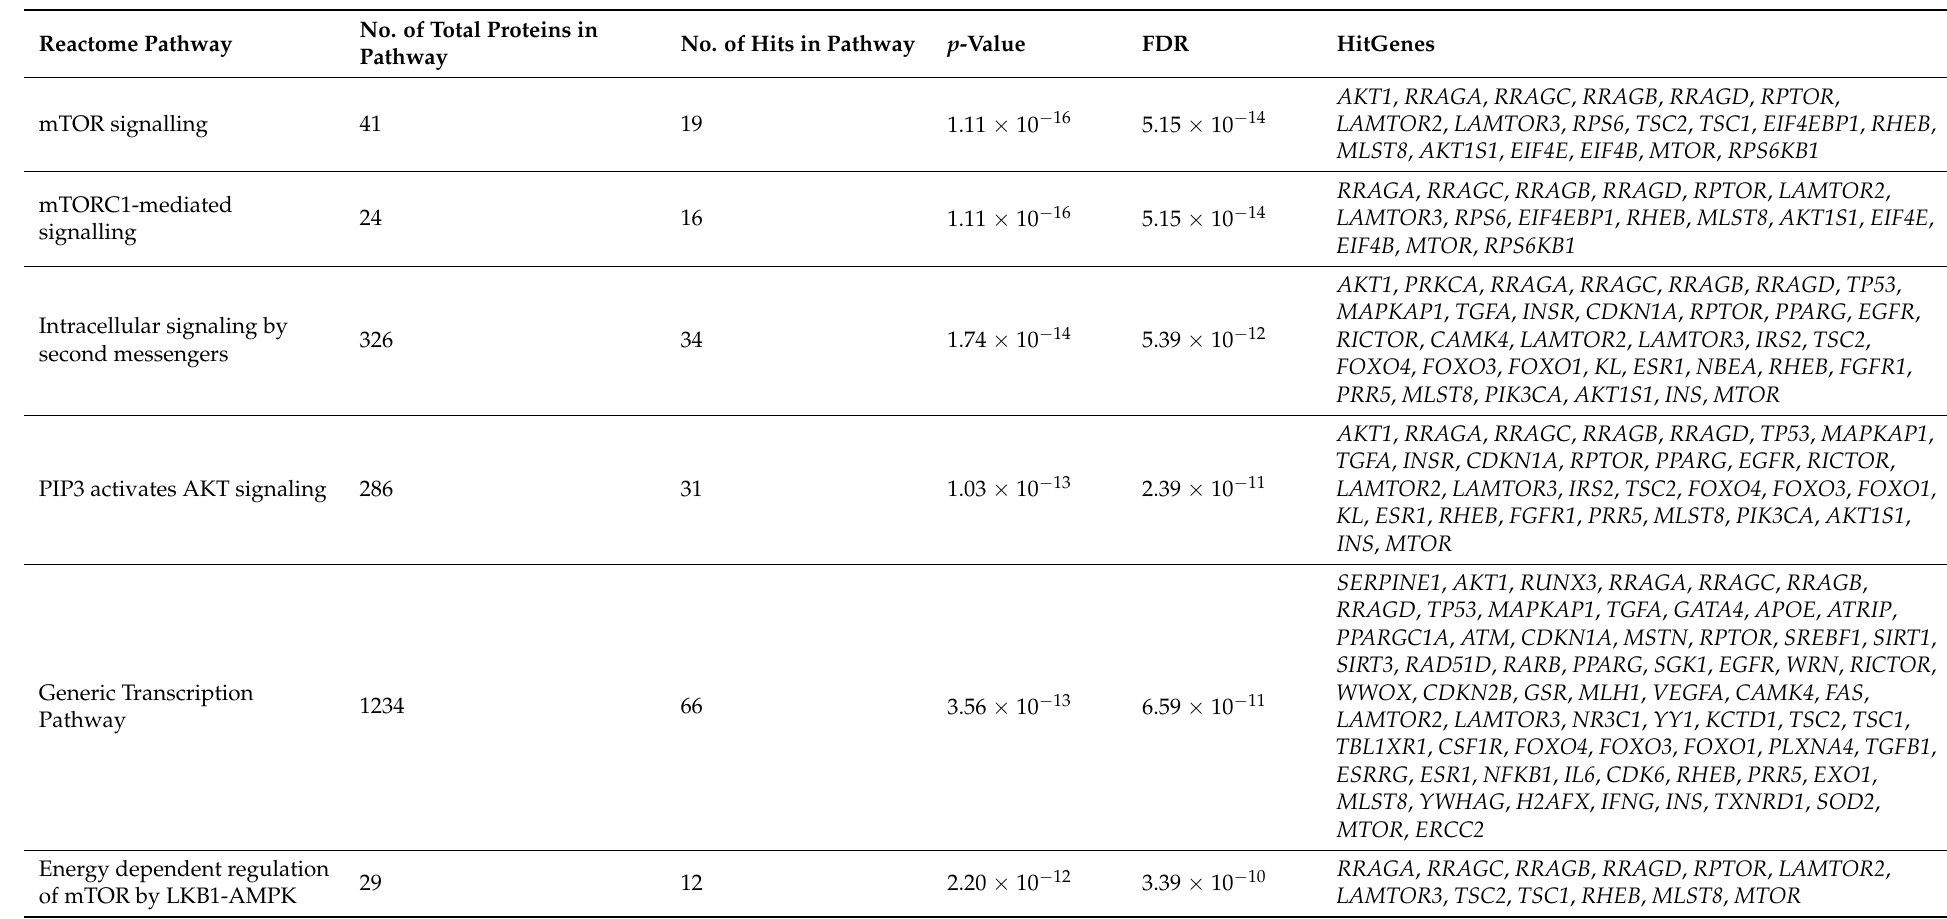
Table 3. Reactome pathway enrichment analysis results—longevity